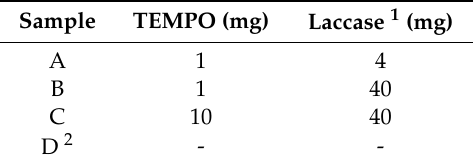
Table 1. Reaction conditions for the TEMPO-mediated laccase oxidation of PS in